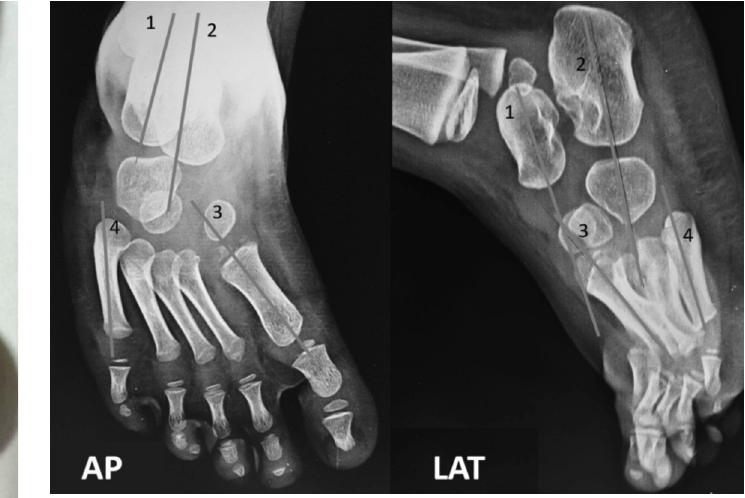
Anteroposterior and lateral image of the foot showing the Fig. 2: radiographic parameters used. (1) Axis of talus. (2) Axis of calcaneum. (3) Axis of 1st metatarsal. (4) Axis of 5th metatarsal. Corresponding angles between these axes were